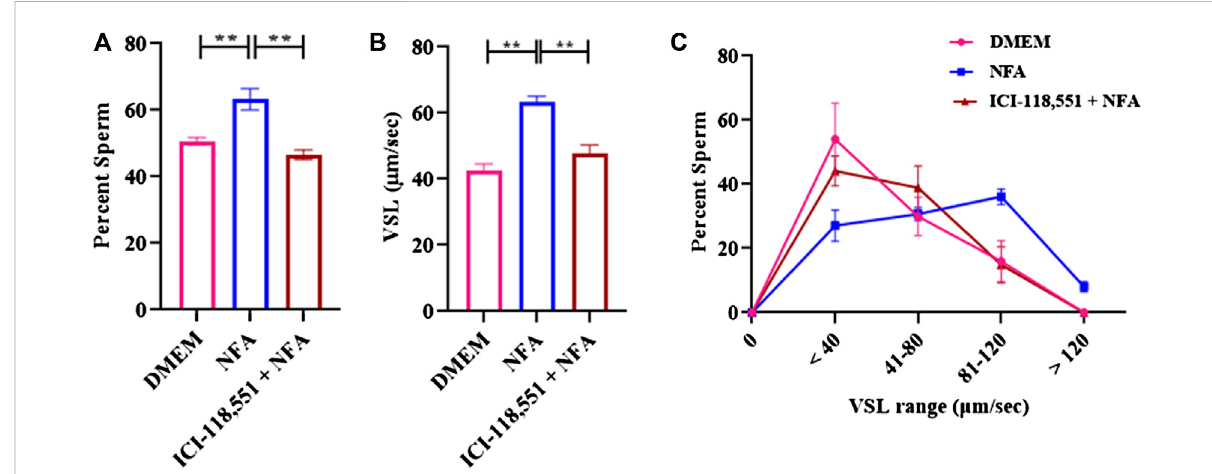
FIGURE 3 β -2-ARantagonistblocksspermchemotacticresponsestoNFA.Theeffectof β -2-ARantagonistonspermchemotaxiswasstudiedafter30 min exposure of capacitating sperm to 0.01 μ M ICI-118,551 before exposing them to a gradient of 0.01 M NFA and evaluating chemotaxis in the micro fl uidics device. Sperm directionality is presented as the percentage of sperm moving toward the ascending concentration gradient of NFA in thetransversechannel (A) ;spermVSL (B) ;andfrequencydistributionofspermVSLundertheseconditions (C) .Eachcolumnrepresentsmean± SD (**p < 0.01). The results represented are cumulative from three independent experiments.